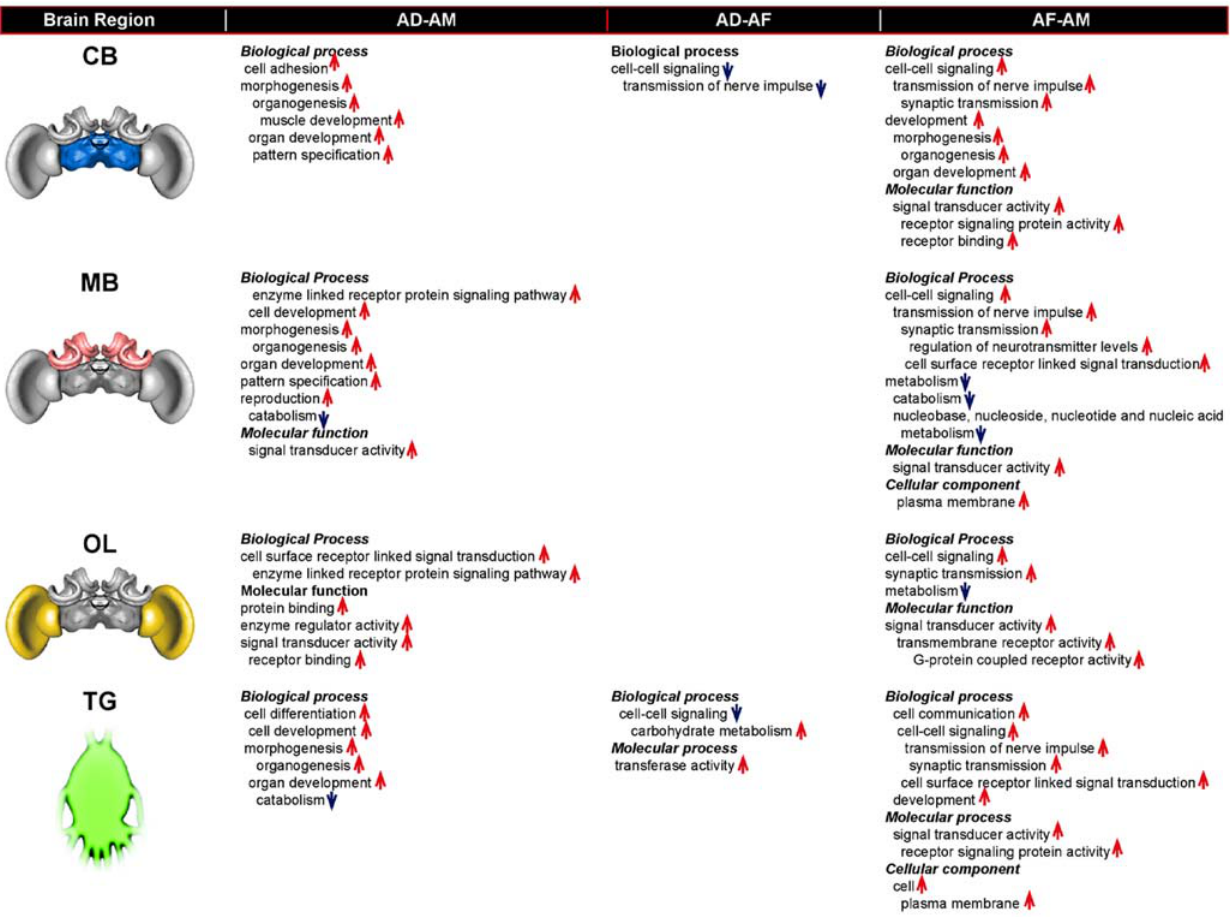
Figure 5. GO enrichment analysis of genes that showed significant differences in expression between species for a given CNS region highlighted in the brain schematic (p , 0.04, Chi-Square test with Yates continuity correction). Upward arrows indicate an overrepresentation of upregulated genes of a given GO class in the first species of the pair, while downward arrows indicate overrepresentation of upregulated genes of a given GO class in the second species of the pair. Abbreviations as in Table 1.